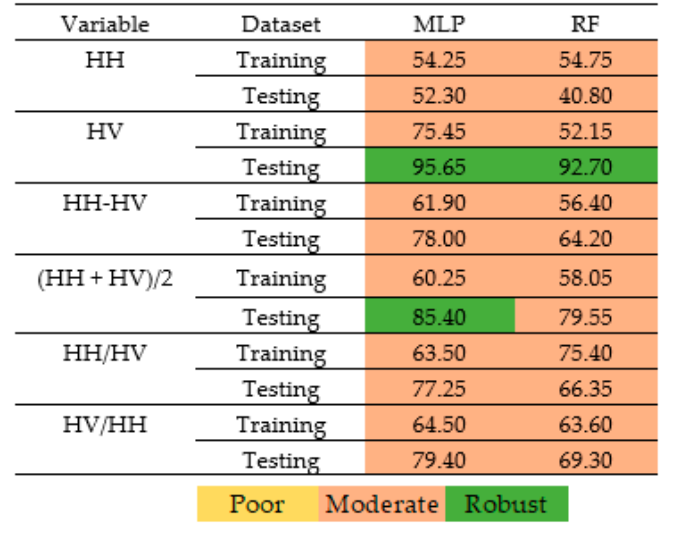
Figure 5. The balanced accuracy (BCR) rate (%) of multilayer perceptron (MLP) and random forests (RF) classifier according to backscatter variables.